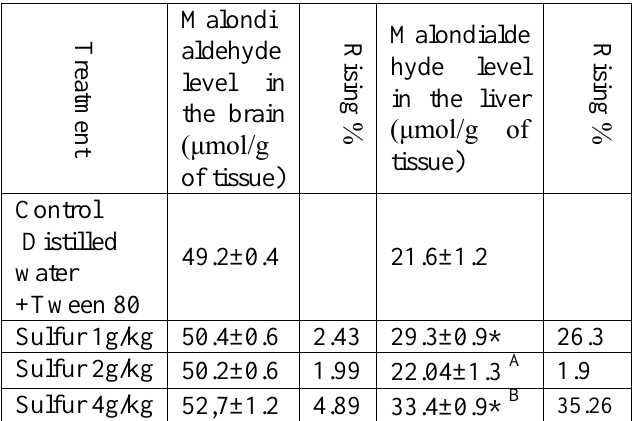
Table 6: Sulfur effect on the MDA level in brain and liver in mice.